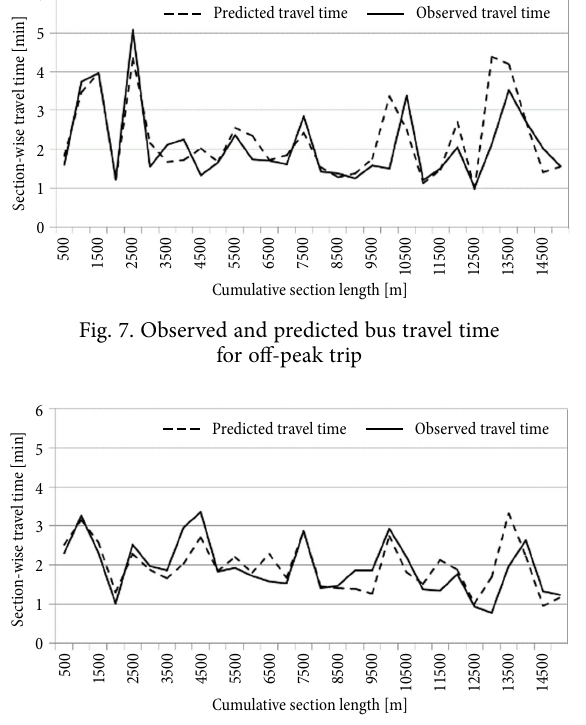
Fig. 8. Observed and predicted bus travel time for peak trip